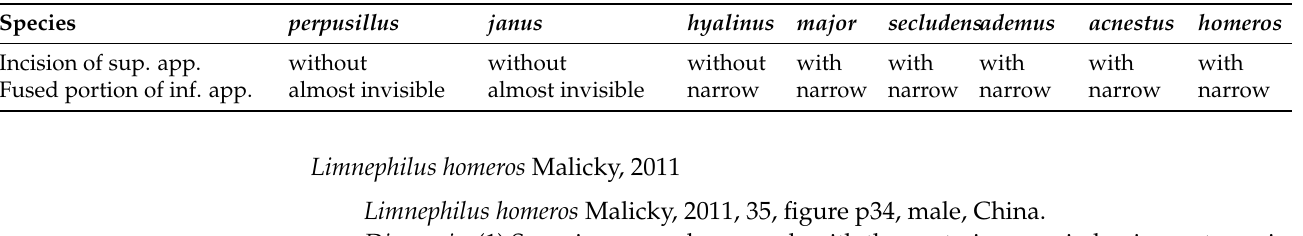
Table 6. Morphological characteristics of superior and inferior appendages of the eight species in the L . perpusillus Species Group nomen novum. Abbreviations: sup. app. = superior appendages; inf. app. = inferior